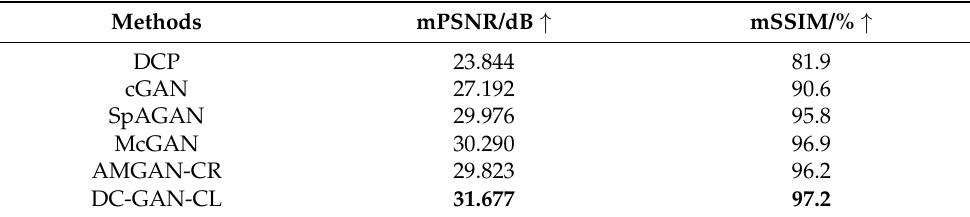
Table 2. Quantitative evaluation of various methods on the RICE1 test